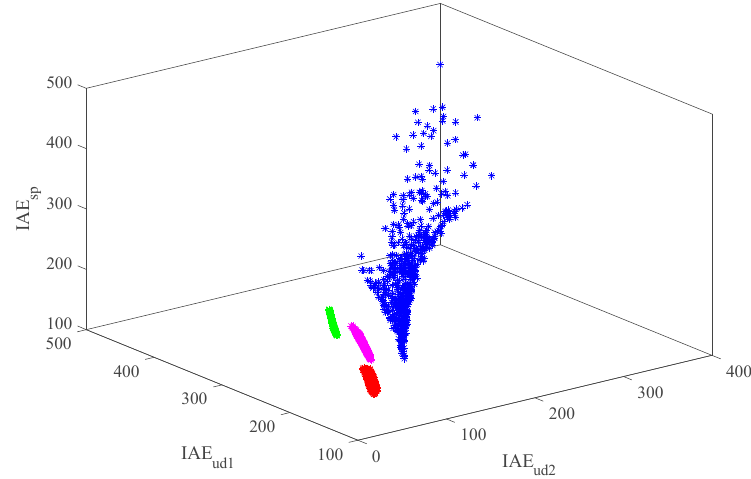
Figure 19. Records of IAE sp , IAE ud2 and IAE ud1 for the perturbed SST system in the simulator. (PI sim -PI: *, PIi-PI: *, ADRC-PI: *, Hybrid ADRC: *)